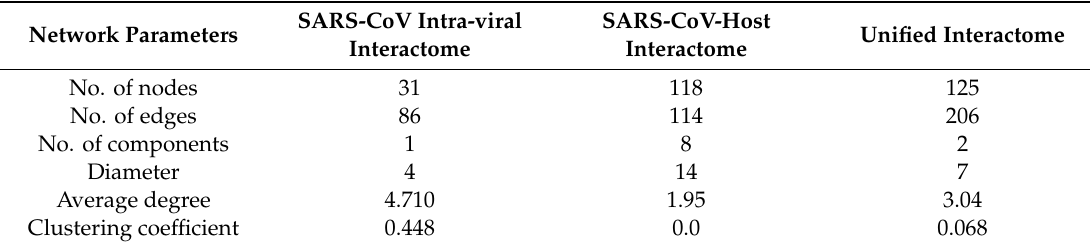
Figure 6. The unified interactome with SARS-CoV-2 interactions inferred through homology. ( A ) The SARS-CoV intra-viral and virus–host interactions are merged to create a unified interaction network indicating the types of proteins; the size of a node reflects the node degree. The SARS-CoV-2 interactions that are inferred from SARS-CoV are represented by green edges, with stars indicating the suspected disruption of the interaction based on the evolutionary conservation of the binding sites. The loops correspond to homo-oligomeric interactions. ( B ) Structural modeling prediction of interaction between SARS-CoV-2 S protein and three monoclonal antibodies. Table 2. Network parameters of the SARS-CoV intra-viral, virus–host and unified networks. The table shows topological statistics for the three networks. Among the many computed statistics, the shown parameters include the number of nodes and edges in the networks, the average degree, number of components (independent networks), diameter (maximum shortest path), and clustering coe ffi